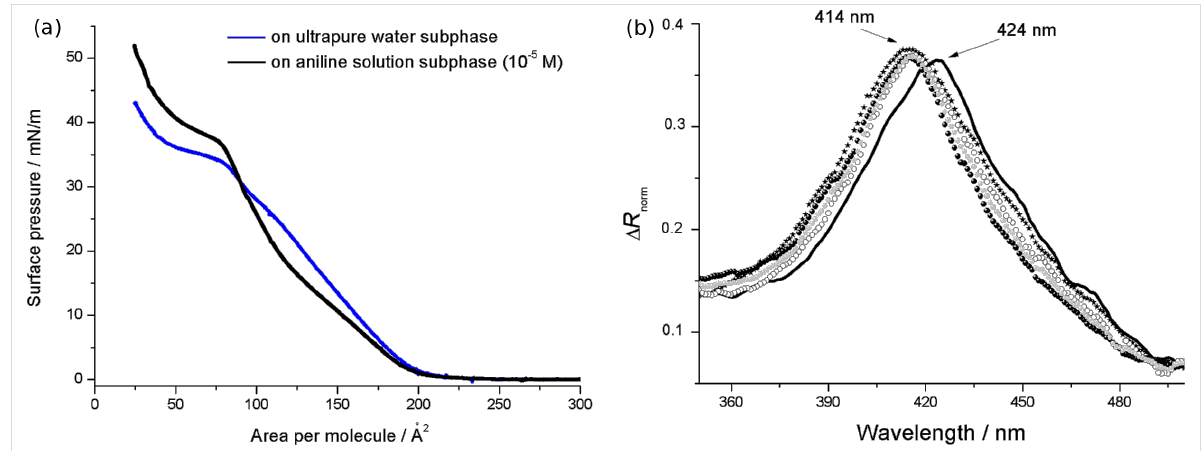
Figure 4: (a) The effect of aniline dissolved in the subphase (10 − 5 M) on the surface pressure vs area per molecule curve (black line) of a bis-por- phyrin derivative, floating layer in comparison to the ultrapure water subphase (grey line). (b) Reflection spectra of the Cu,H 2 -Por 2 floating film in the presence of aniline in the subphase (solid black line) in comparison with the reflection spectra of the bis-porphyrin Langmuir film spread on ultrapure water (filled black circles) and tert -butylamine (stars), putrescine (unfilled circles) and diaminocyclohexane (filled grey circles) aqueous solutions (all the analytes were dissolved in a concentration of 10 − 5 M). All the spectra were recorded at a surface pressure of 12 mN/m and appropriately multi- plied or divided in order to have the same maximum value of Δ R of the Cu,H 2 -Por 2 floating layer on the ultrapure water subphase.